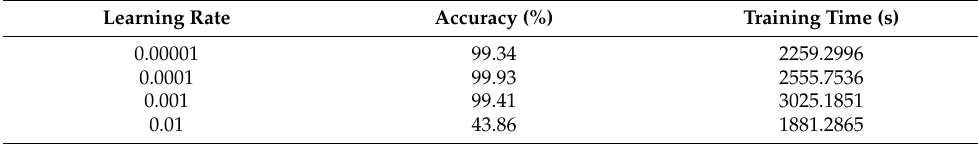
Table 3. Accuracy at different learning rates R [ B = 32, I = 64 × 64, θ = Adam].